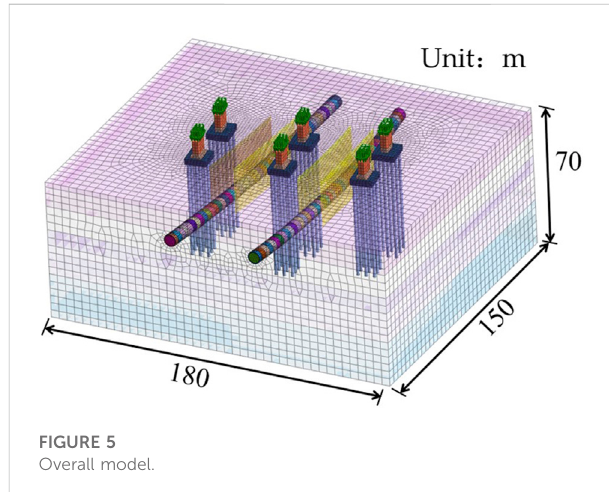
FIGURE 4 Layout of the pier measuring